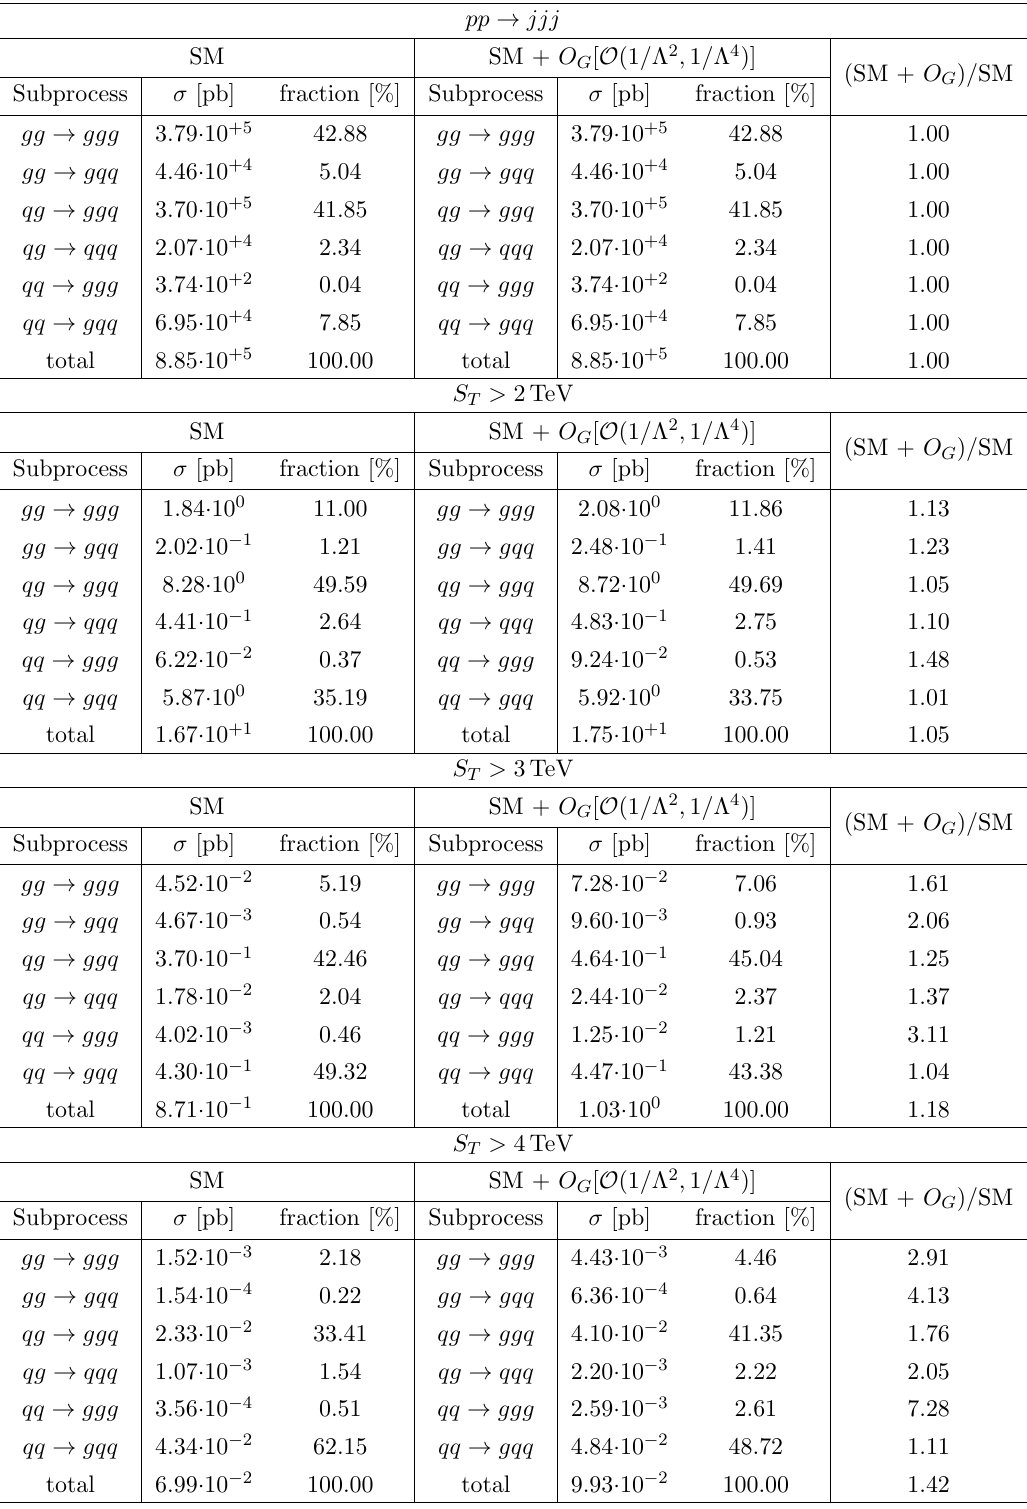
Table 4 . Contributions from the di(cid:11)erent partonic subprocesses contributing to the production of three partonic jets at LHC13 in the SM ( O (1 = (cid:3) 0 )) and when allowing at most one O G insertion in the amplitudes ( O (1 = (cid:3) 2 ) and O (1 = (cid:3) 4 )).